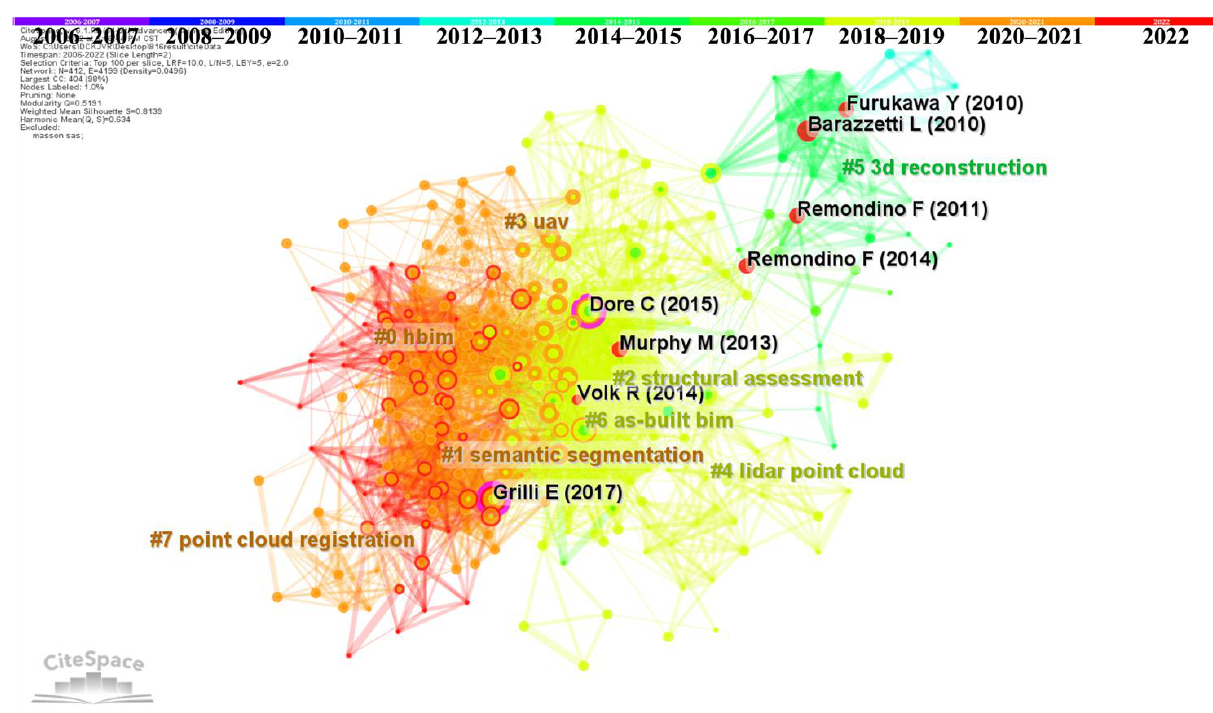
Figure 6. The visualization of the document co-citation network for the years 2006 – 2022.